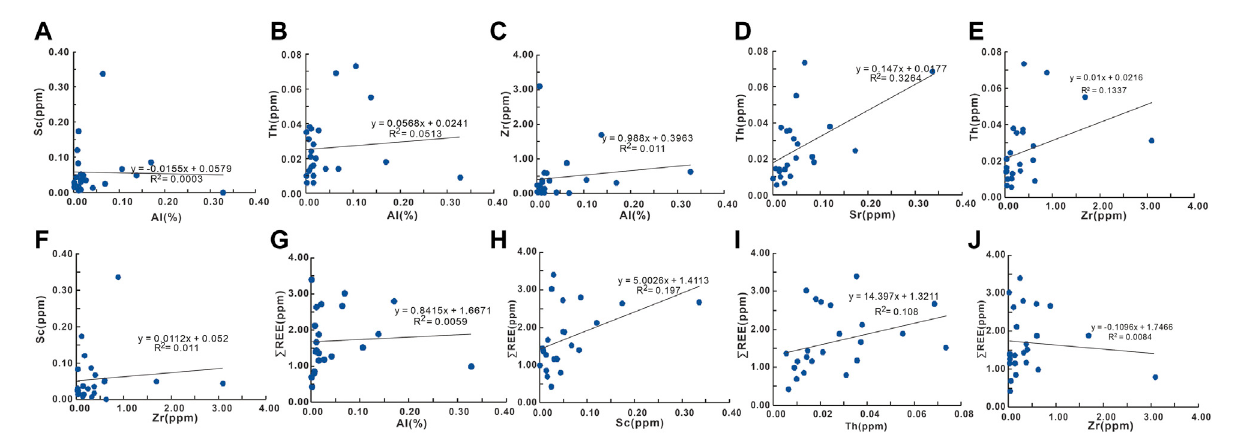
FIGURE 7 Cross-plotsshowingtheconcentrationcorrelationsof (A) AlandSc; (B) AlandTh; (C) AlandZr; (D) ScandTh; (E) ZrandTh; (F) ZrandSc; (G) Aland (cid:1) REE; (H) Sc and (cid:1) REE; (I) Th and (cid:1) REE; (J) Zr and (cid:1)